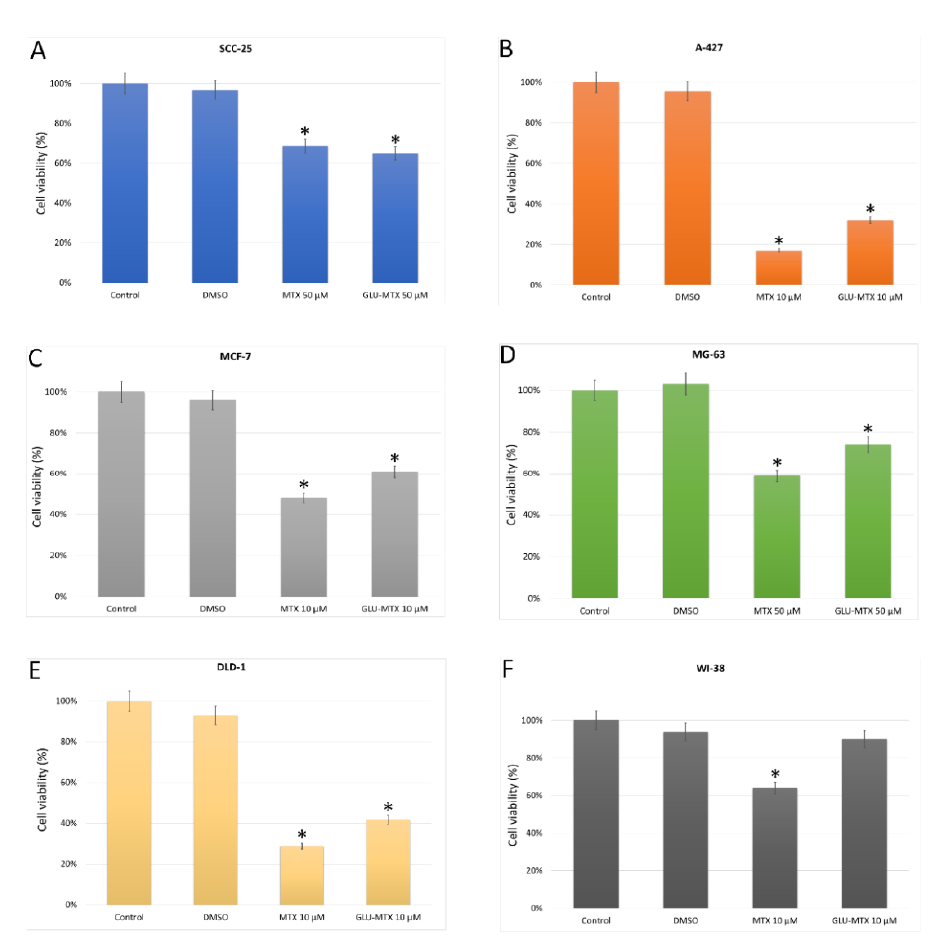
Figure 2. Cell viability of various human cancer cell lines: squamous cell carcinoma SCC-25, lung carcinoma A-427, human colon adenocarcinoma DLD-1, breast carcinoma MCF-7, osteosarcoma MG-63 ( A – E ) and normal human fibroblast WI-38 ( F ) after MTX and GLU–MTX treatment for 48 h at doses 10–50 µ M. Results are presented as means ± standard deviations from three independent experiments. * p < 0.05 vs.